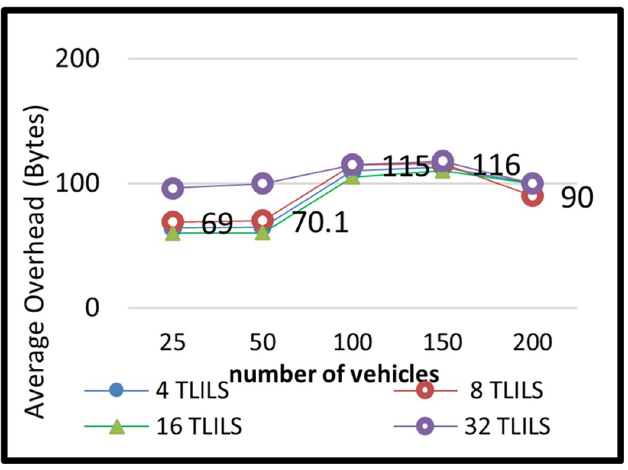
Fig 11. Overhead of information dissemination with the TLILS with 10 m/s